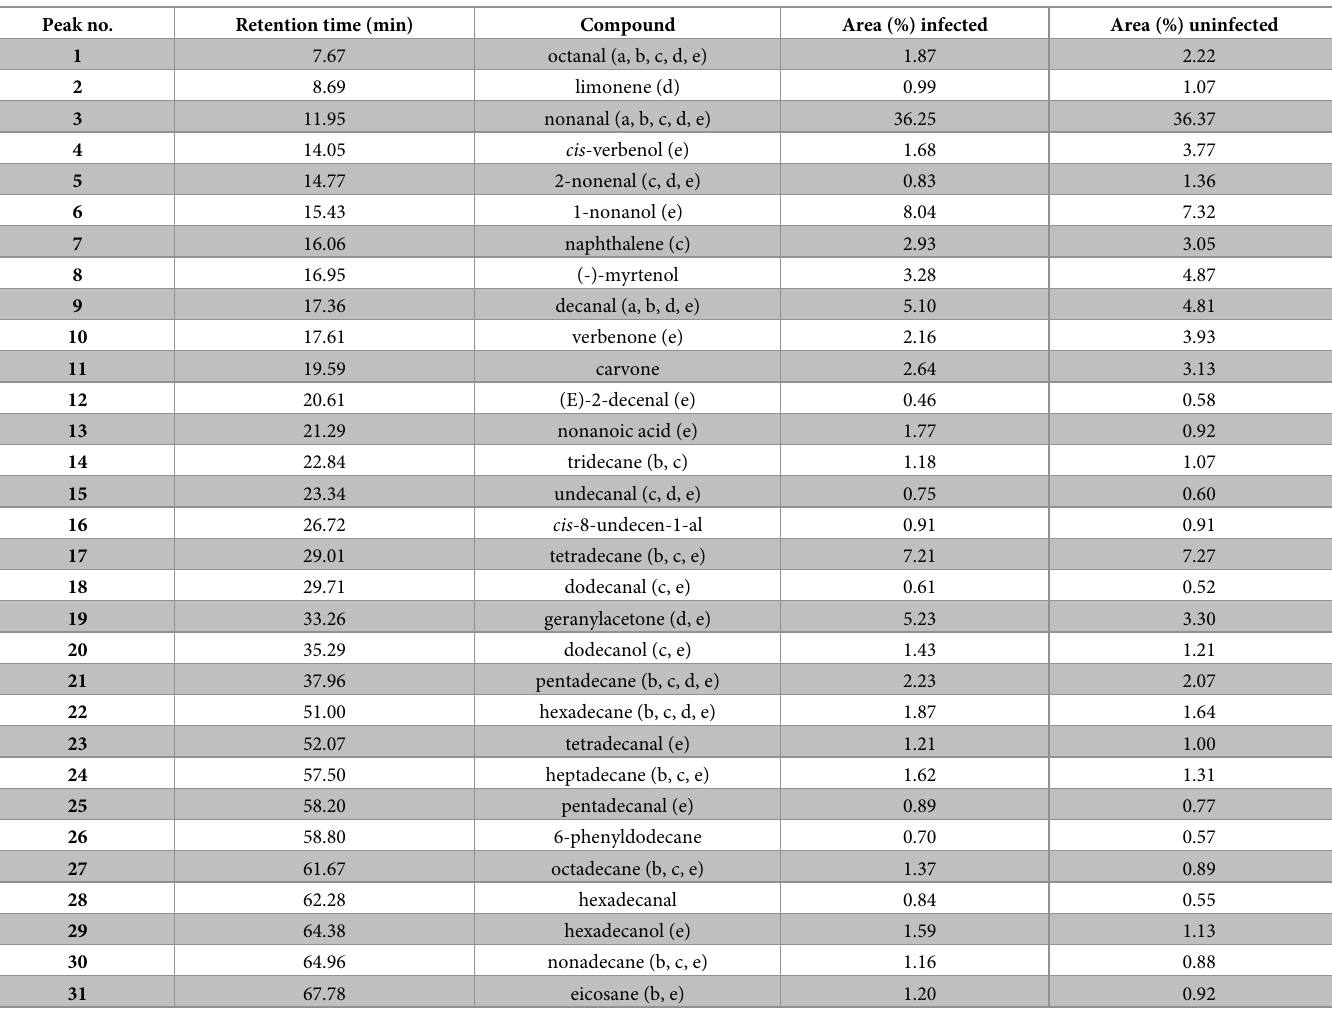
Table 2. Volatile compounds tentatively identified based on retention time (in ascending order) and relative areas for infected and uninfected mice. Peak